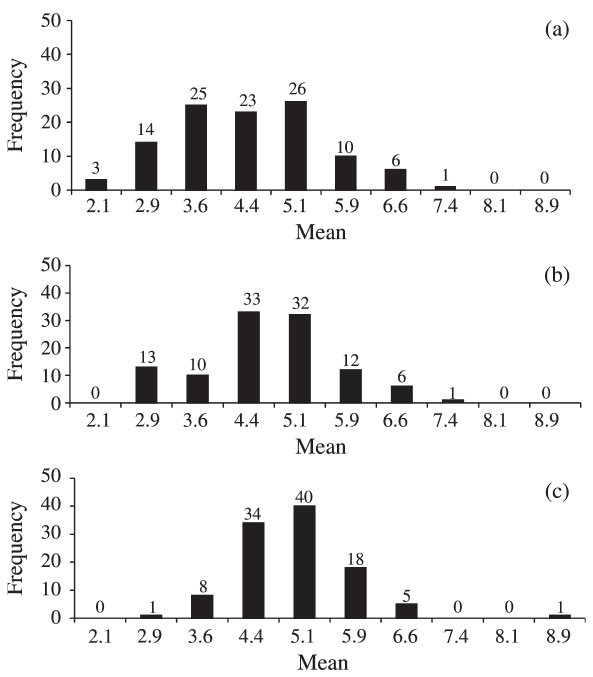
Figure 1 - Frequency distribution of the grain yield means in t/ha of the families derived from F 2 (a), F 8 (b) and F 24 (c) plants. Average of three sowing